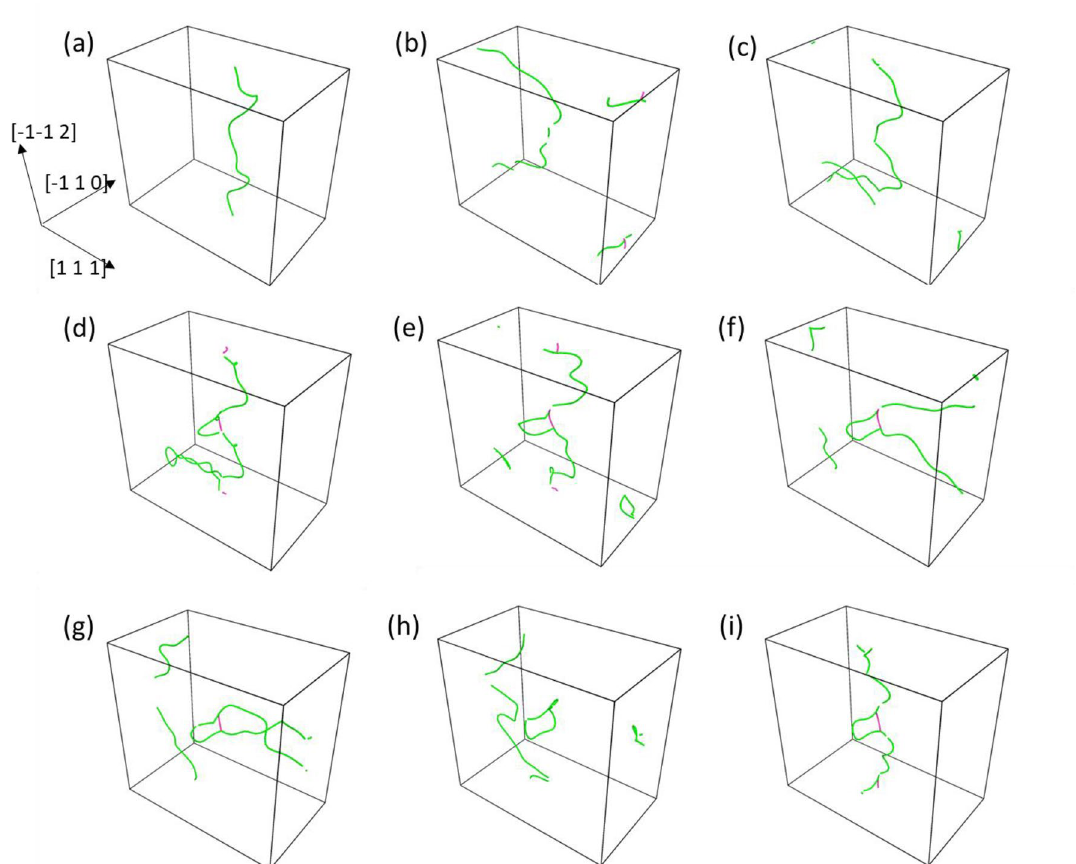
Figure 5. Perspective images of dislocation core movement through the simulation box of 10 MC swap structure under application of CRSS sequentially obtained by DXA method. Green lines denote ½ <1 1 1> family of dislocation Burgers vector and pink line denotes <1 0 0> family of Burgers vectors. Figure made using OVITO 2.9.0. URL: https ://www.ovito